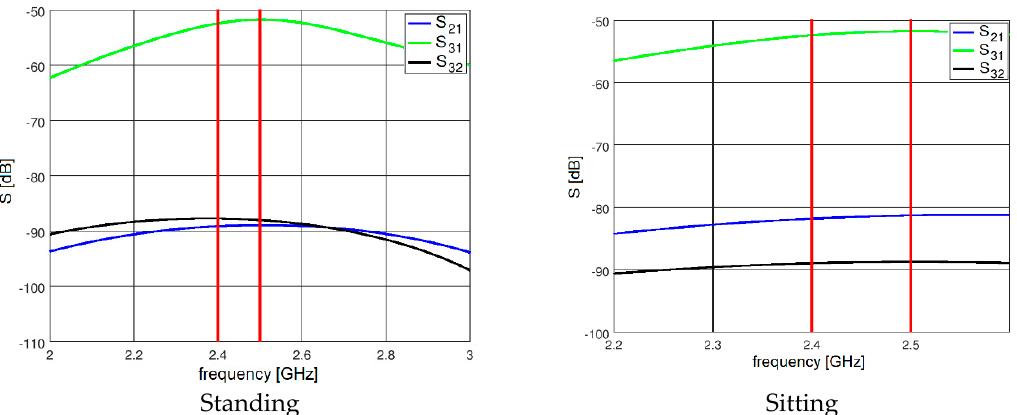
Figure 17. The S parameters for the final solution.